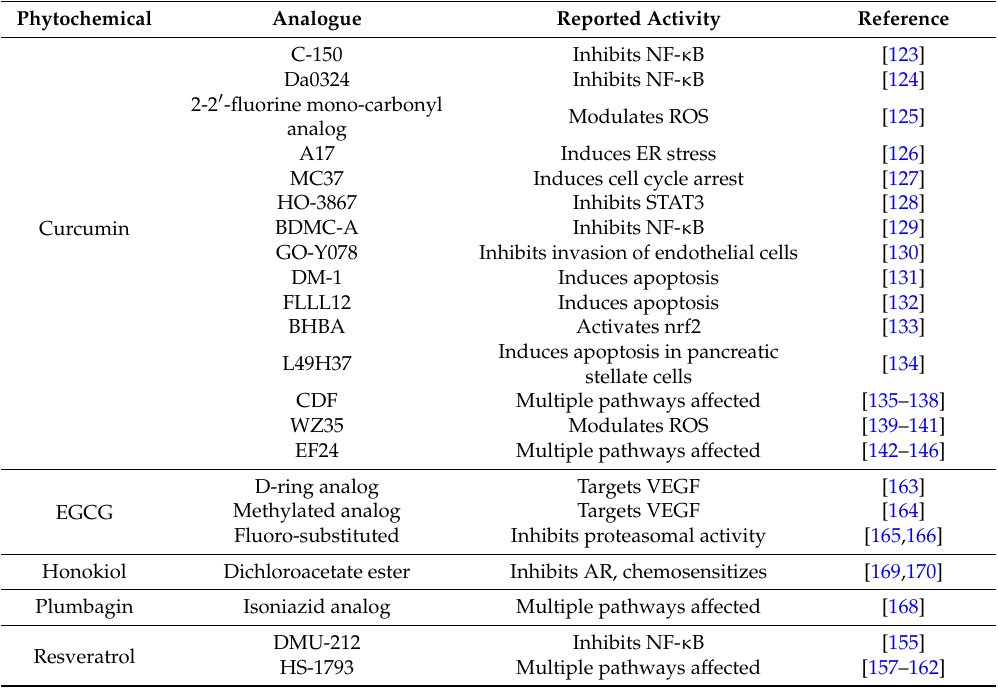
Table 3. Chemical analogues of phytochemicals and their reported